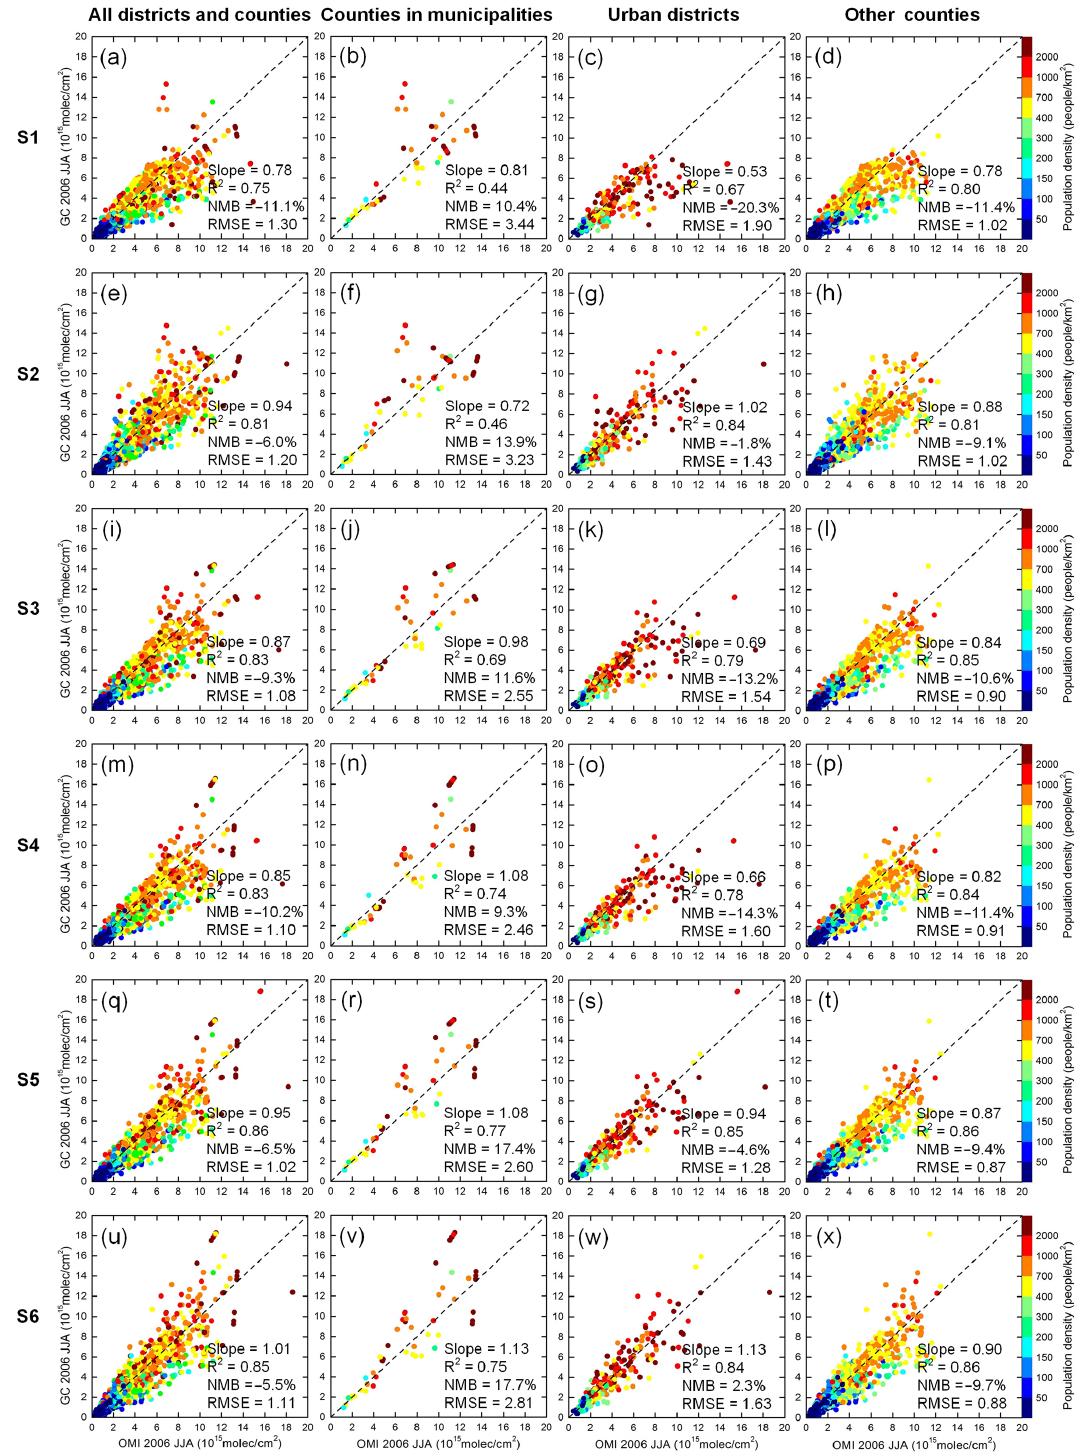
Figure 5. Comparisons between county-level model simulations from the six emission cases and OMI NO 2 vertical columns for all counties (first column), urban districts in municipalities (second column), urban districts in other cities (third column), and other counties (fourth column). The color of each symbol corresponds to the population density in the county specified by that symbol. The dotted line has a slope of